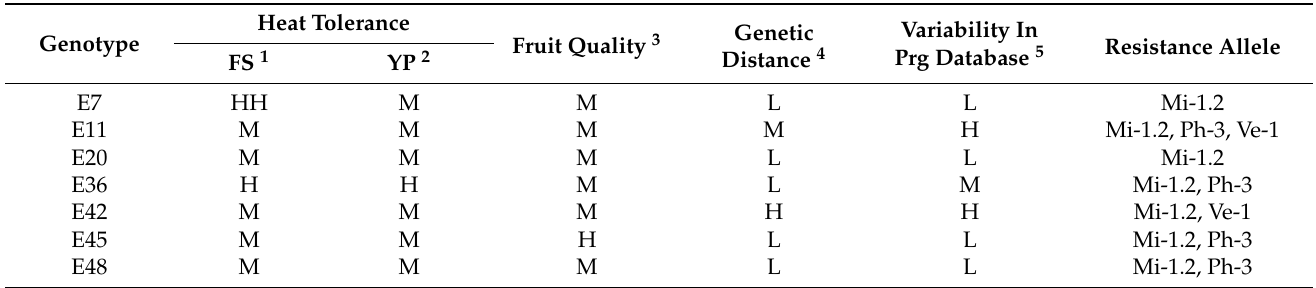
Table 2. Summary of the phenotypic analyses and the molecular screening of resistance genes carried out in 15 parental genotypes. The resistant allele detection is reported for six genes: Mi-1.2, Root-knot nematode resistance; Ph-3, late blight resistance; Sw-5, Tomato spotted wilt virus; Tm-2, Tomato mosaic virus resistance; Ty-3, Tomato yellow leaf curl virus resistance; Ve-1, Verticillium wilt resistance. Scores of heat tolerance, fruit quality traits, genetic distance, variability in PRG database of parental genotypes are also reported. HH, very-high; H, high; M, medium; L, low.